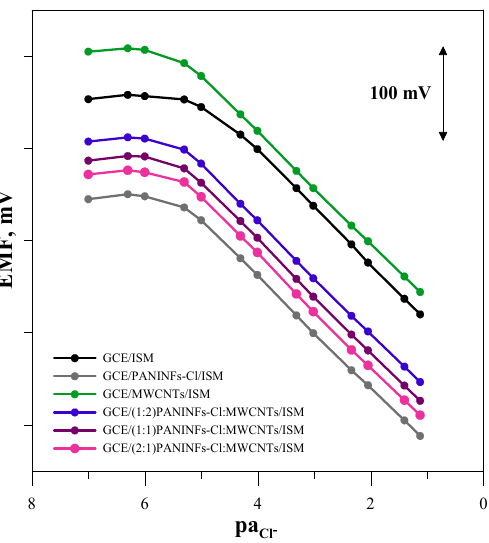
Figure 6. Potentiometric calibration plots recorded for the tested electrodes in NaCl solutions (concentration range 10 − 7 –10 − 1 mol L − 1 ). Table 4. Selected analytical parameters obtained for the tested